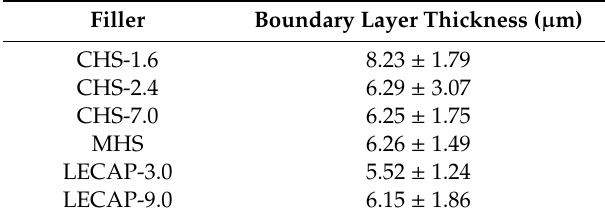
Table 6. The relative density and mechanical properties of the produced metal matrix syntactic foams (MMSFs).